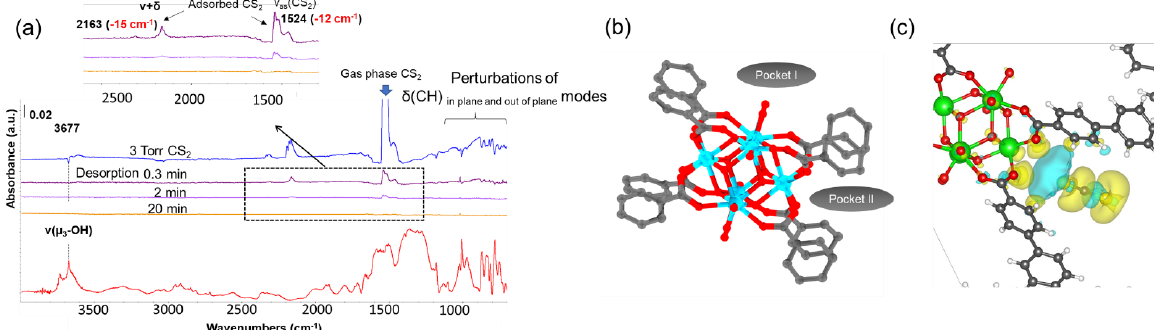
Figure 4. ( a ) difference IR spectra of 1 during adsorption (~3 min, top) and desorption (middle three) of CS 2 , referenced to activated MOF in vacuum (bottom). The CS 2 gas signal of asymmetric stretching band ν 3 at 1560–1400 cm − 1 is not fully shown due to its prohibitively high intensity. ( b ) The two distinct pockets in the MOF structure that are surrounded by Zr-O bonds. ( c ) Charge rearrangement diagram showing an increase in electron density (yellow) and loss of electron density (cyan) upon CS 2 interaction at an isolevel of 2 × 10 − 4